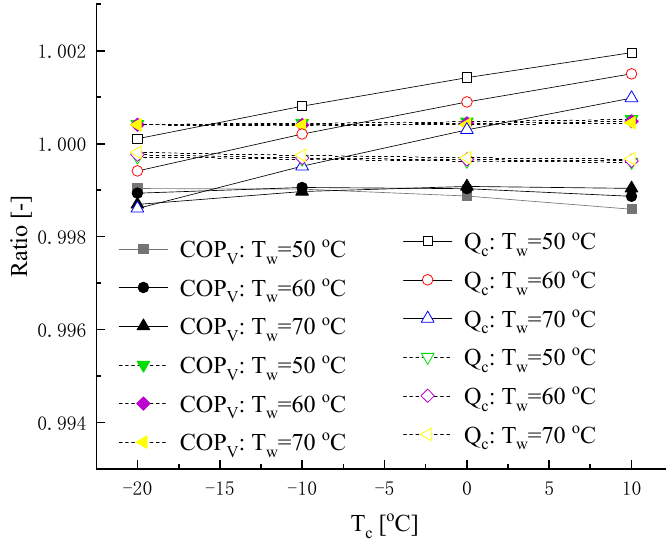
Figure 7. Ratios of COP V and Q c in FCVM and VPBVM over TCVM at various conditions.